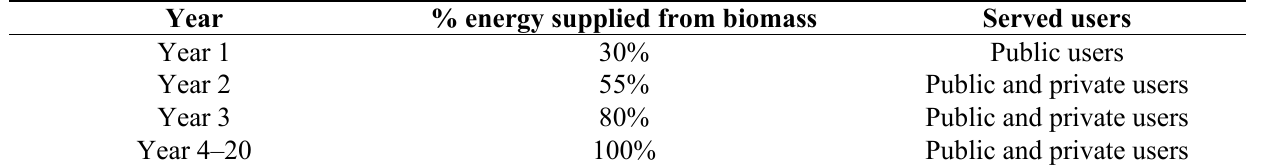
Table 9. Share of energy from biomass. Source: elaboration of the